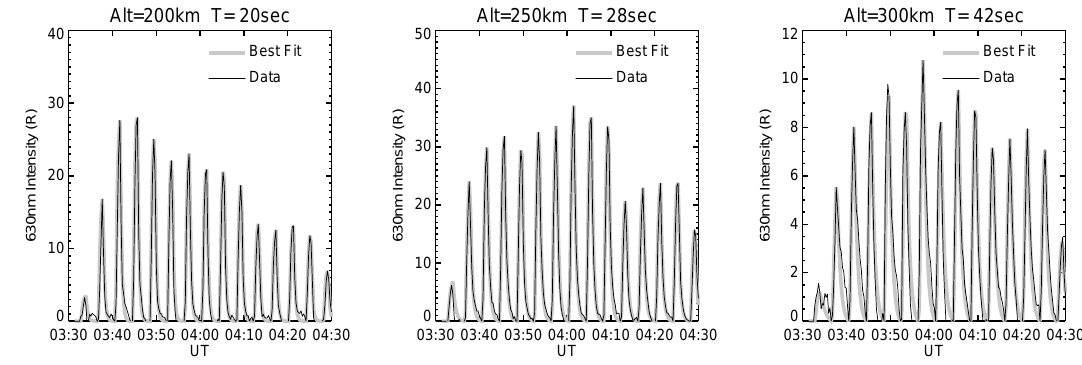
Fig. 7. Sample comparisons of modeled 630.0nm emission intensities (thick gray line) and background-subtracted measurements (thin black line) for altitudes of 200, 250, and 300km and the effective lifetime time constants plotted in Fig. 6.